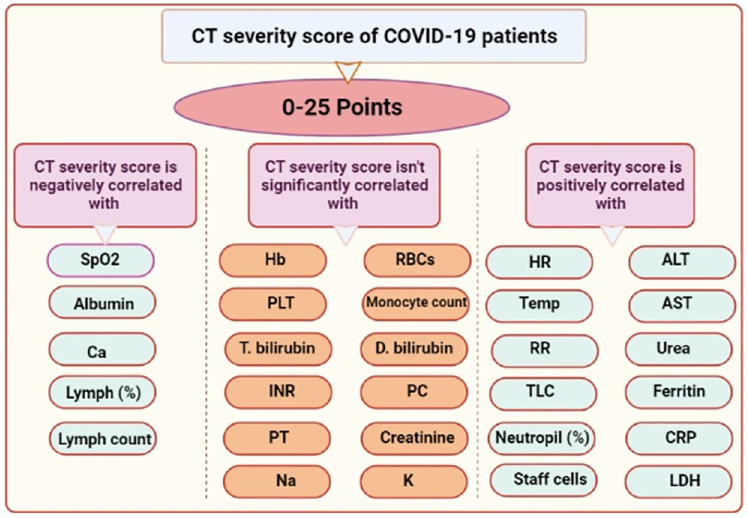
Fig 3. Schematic diagram for the association between different clinical laboratory data and CT severity score in COVID-19 patients.